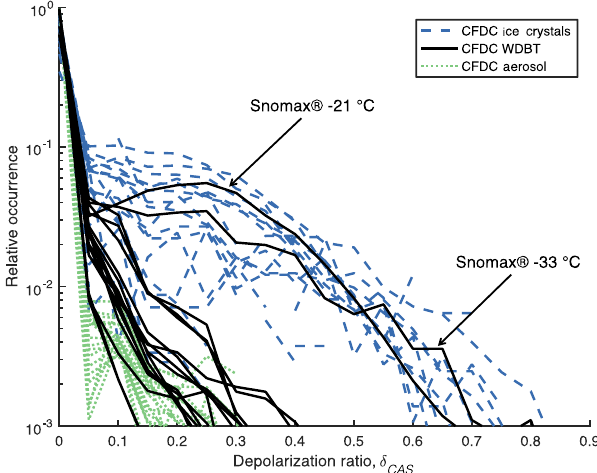
Figure 5. Frequency distribution of depolarization ratios for CFDC populations: ice crystal periods (19 periods classified), WDBT pe- riods (17 periods classified), and aerosol periods (19 periods clas- sified). Mean temperatures of periods included range from − 15 to − 35 ◦